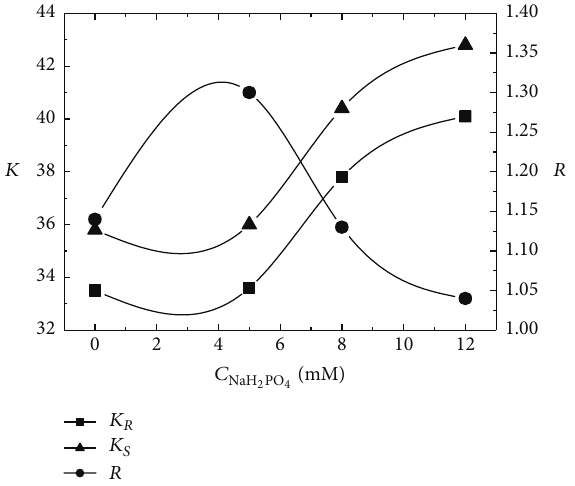
Figure 4: Effect of the concentration of sodium dihydrogen phosphate. Mobile phase: aqueous buffer/methanol/acetonitrile of , concentration of sodium dihydrogen 21: 3 :1 (v/v/v), C NaH 2 PO 4 phosphateinaqueousbufferof0,5,8,and12 mM,12mMSBE- 𝛽 -CD, pH of 2.5, flow rate of 1.0mL/min, detection wavelength of 240 nm, temperature of 25 ∘ C, 𝐾 𝑅 and 𝐾 𝑆 , and retention factors of ( 𝑅 )-CIT and ( 𝑆 )-CIT, respectively; 𝑅 , resolution.